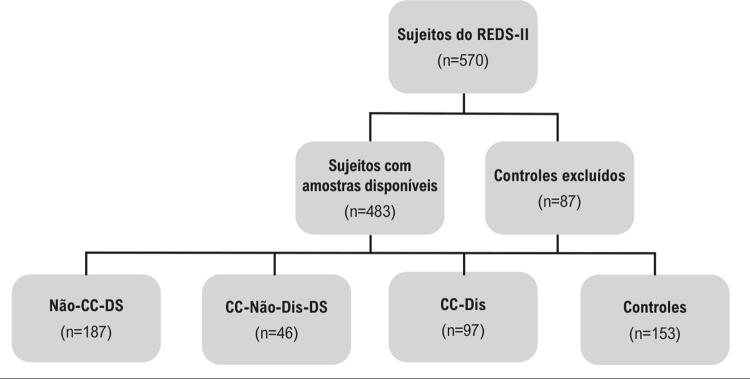
– Fluxograma de inclusão.